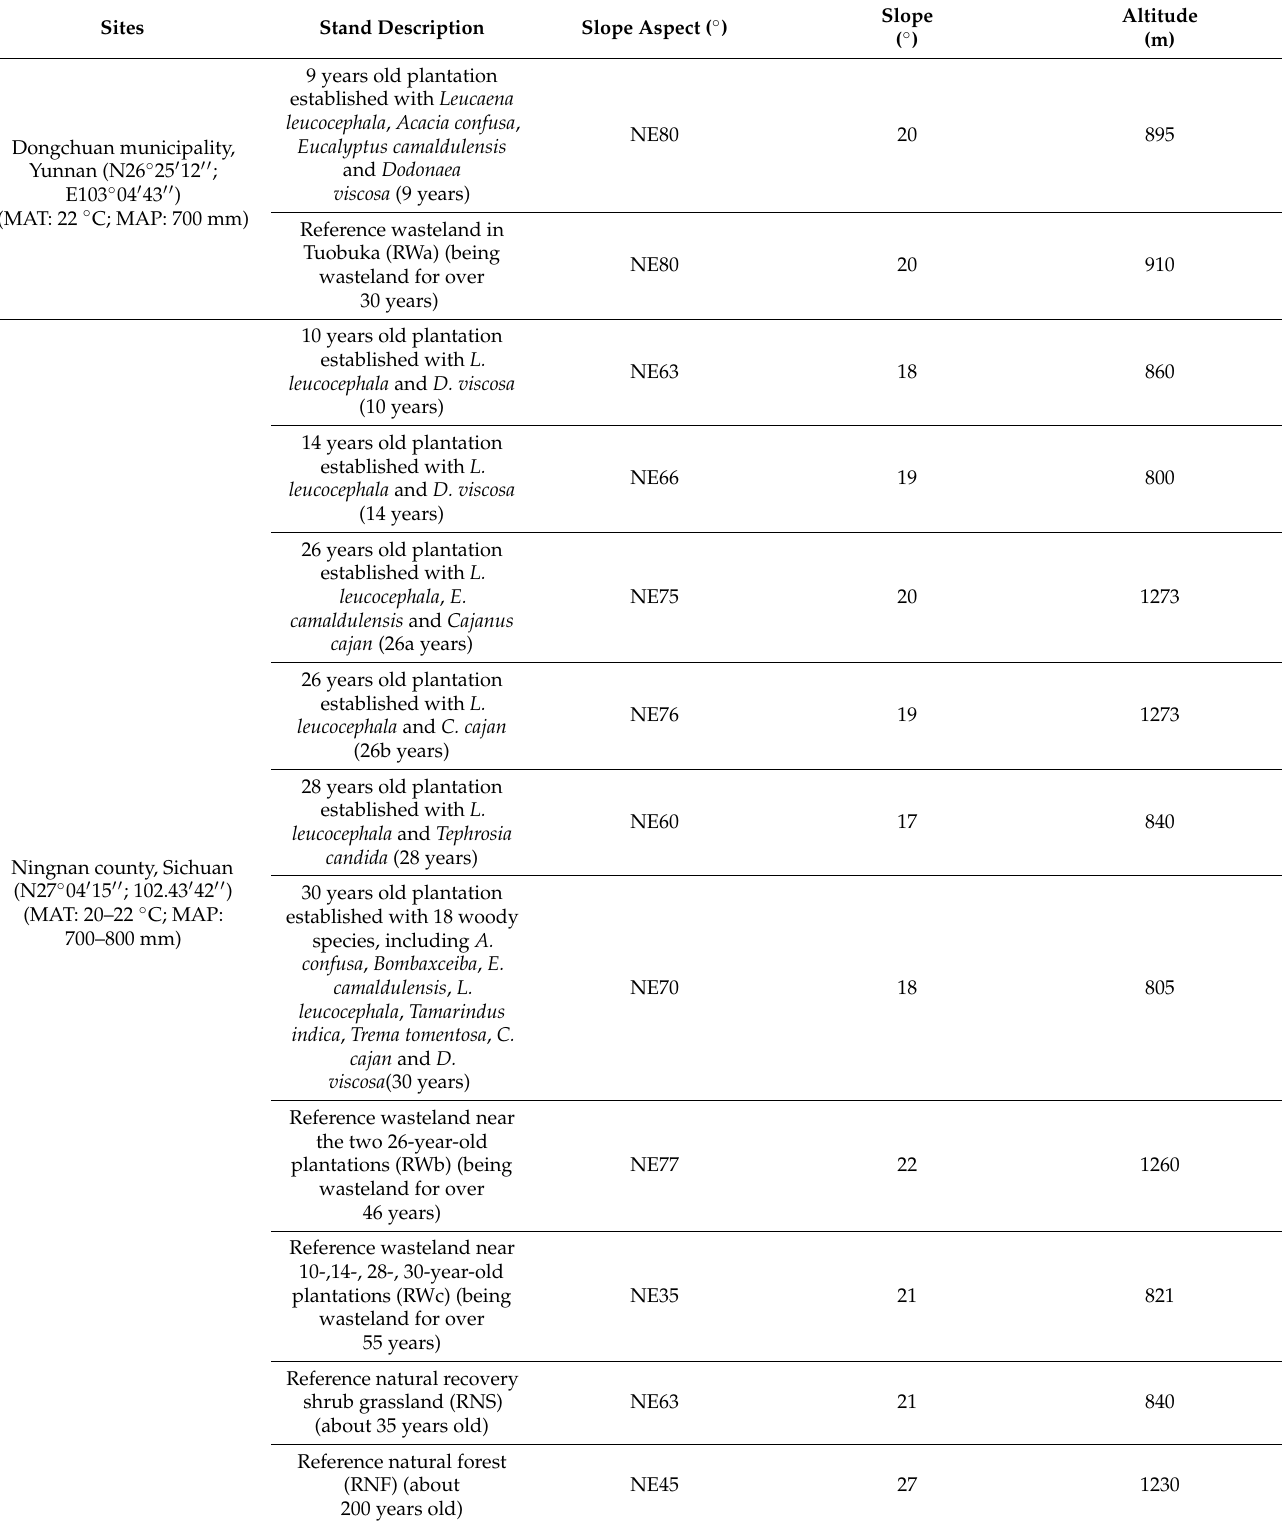
Table 1. Description of the sampling